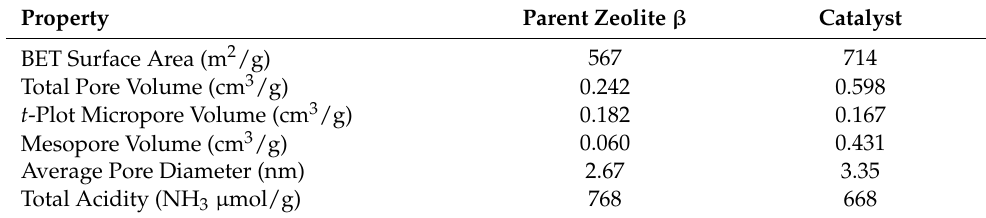
Table 1. Textural and acidic properties of